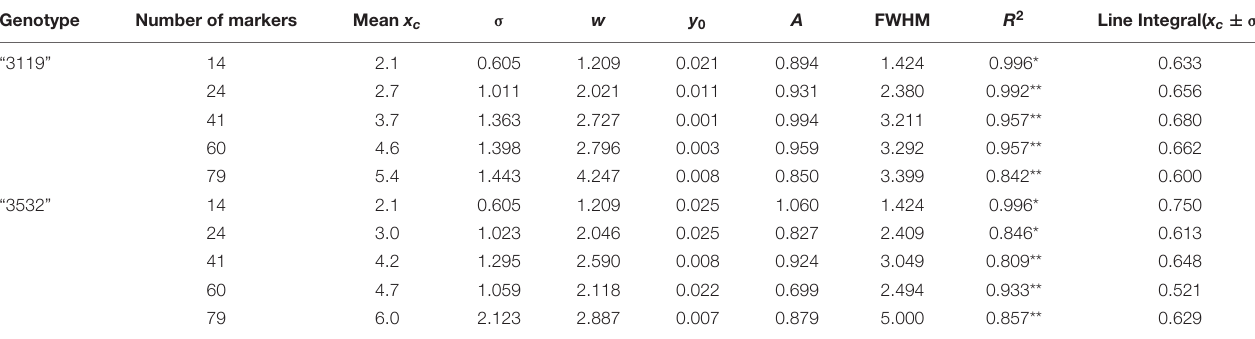
TABLE 1 | Normal fitting parameters under different number of markers detected. Genotype Number of markers